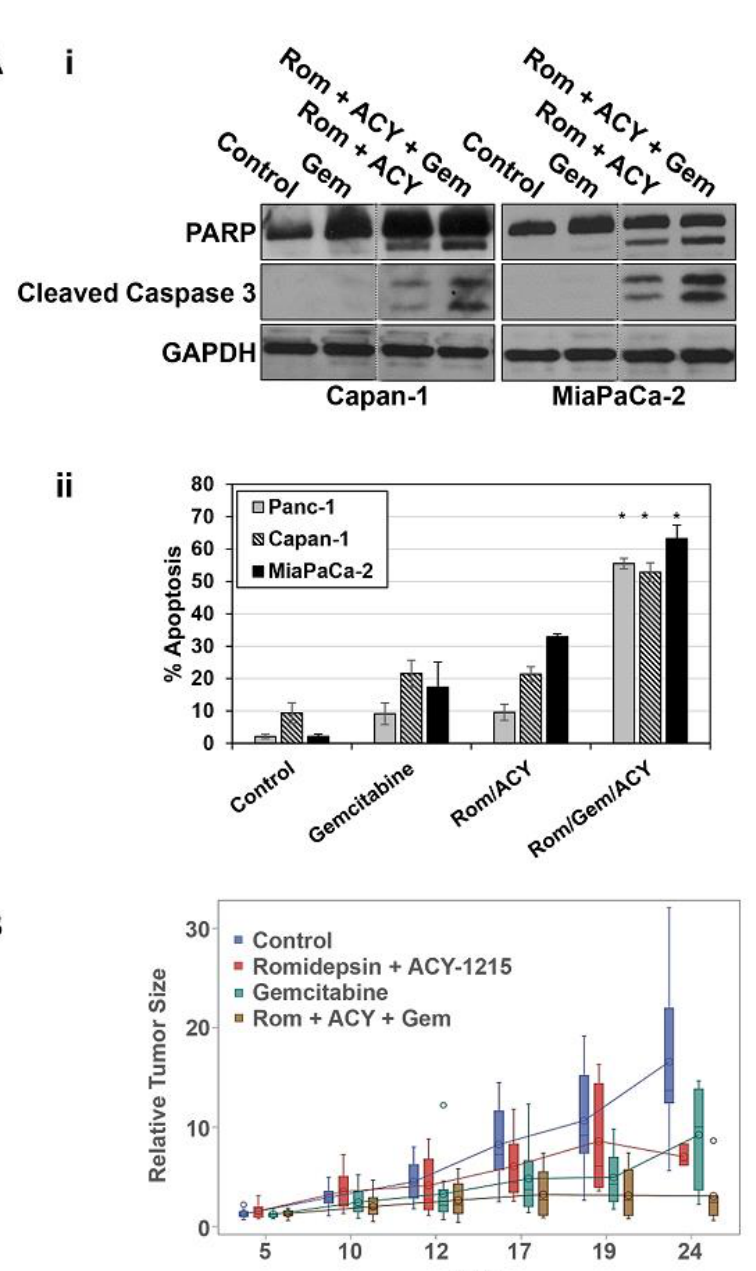
Figure 5. Pharmacological inhibition of HDACs 1, 2, and 6 enhances the effects of gemcitabine on PDAC cells in vitro and in vivo. ( A.i ) The indicated cells were treated with vehicle, 40 nM gemcitabine (Gem), 8 nM Romidepsin (Rom), and/or 1 µM ACY-1215 (ACY) for 48 h, and the expression of PARP, cleaved caspase 3, and GAPDH was determined by Western blotting. Vertical lines indicate rearrangement of lanes from a single membrane for clarity. Data are representative of three independent experiments. ( A.ii ) PDAC cells treated as in ( i ) were analyzed for apoptosis based on cell surface phosphatidylserine using Annexin V-FITC. Data are means ± s.e. * Significantly different from Gemcitabine and Rom/ACY, p < 0.05, n = 3. ( B ) Athymic nude mice bearing subcutaneous Capan-1 xenografts (16 per group) were given intraperitoneal injections of vehicle, Romidepsin plus ACY-1215, gemcitabine, or Romidepsin plus ACY-1215 plus gemcitabine, as described in Materials and Methods. Tumor volumes at various time points were normalized to the volume on day 0 for each mouse. Changes in tumor growth were analyzed with a mixed model and are displayed with 95% confidence intervals.